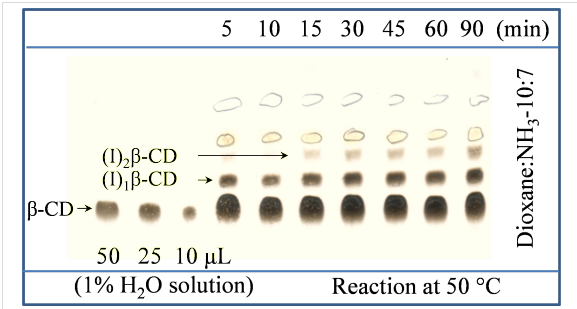
Figure 1: TLC study of β -CD iodination showing the proceeding of 6-monoiodination with increasing reaction time.